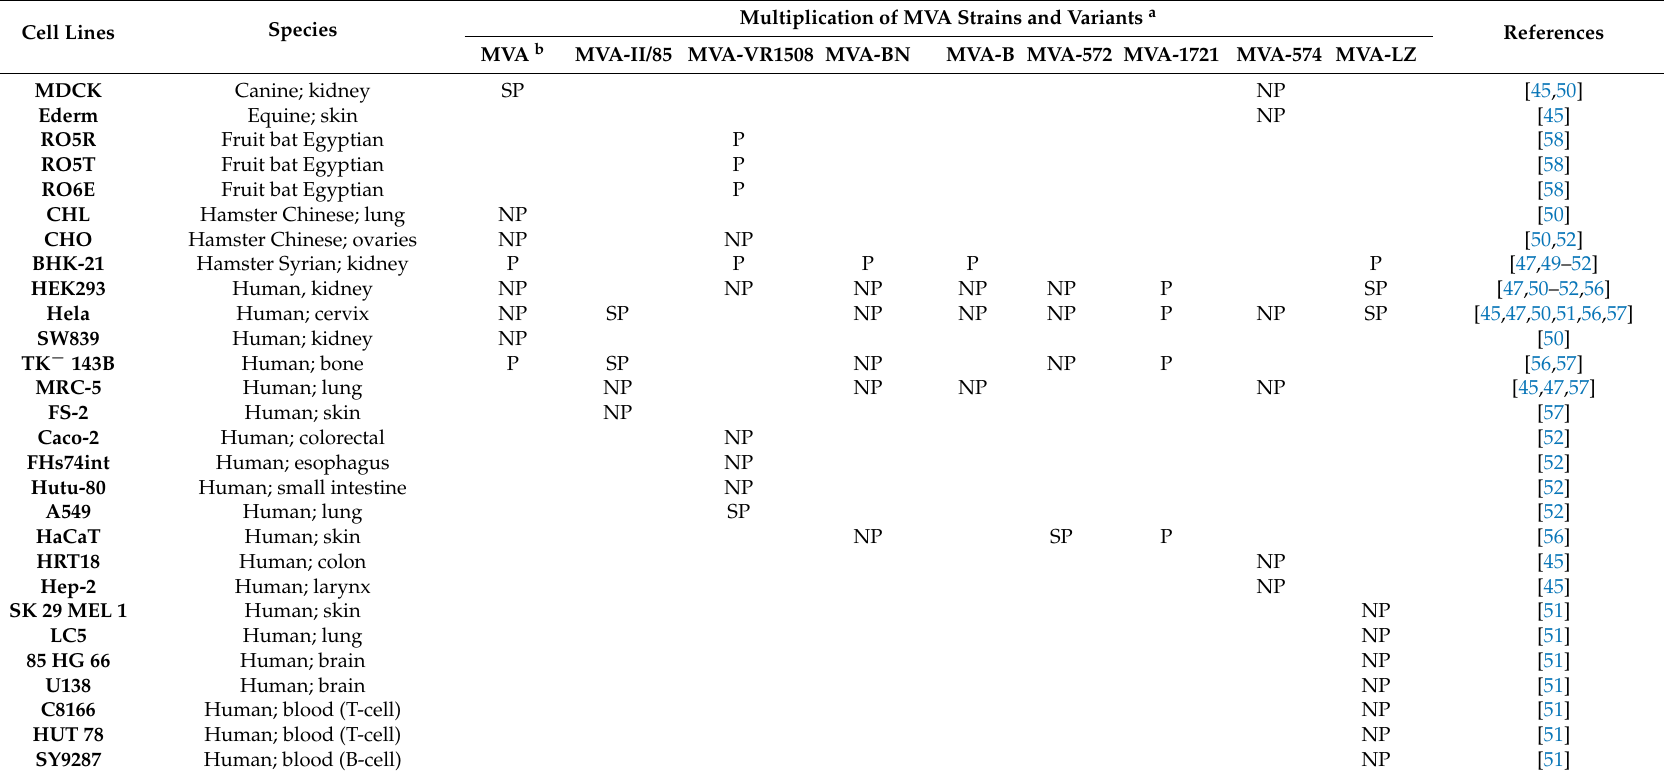
Table 1. Susceptibility of mammalian cell lines to modified vaccinia virus Ankara (MVA)